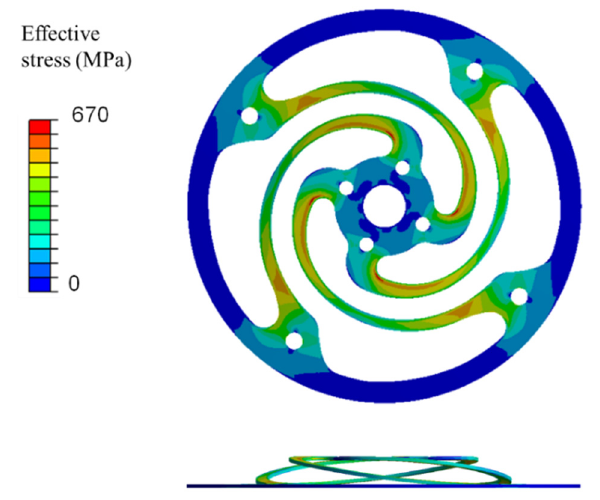
Figure 11. Result of stress analysis. Table 4. Result of CCD Case.